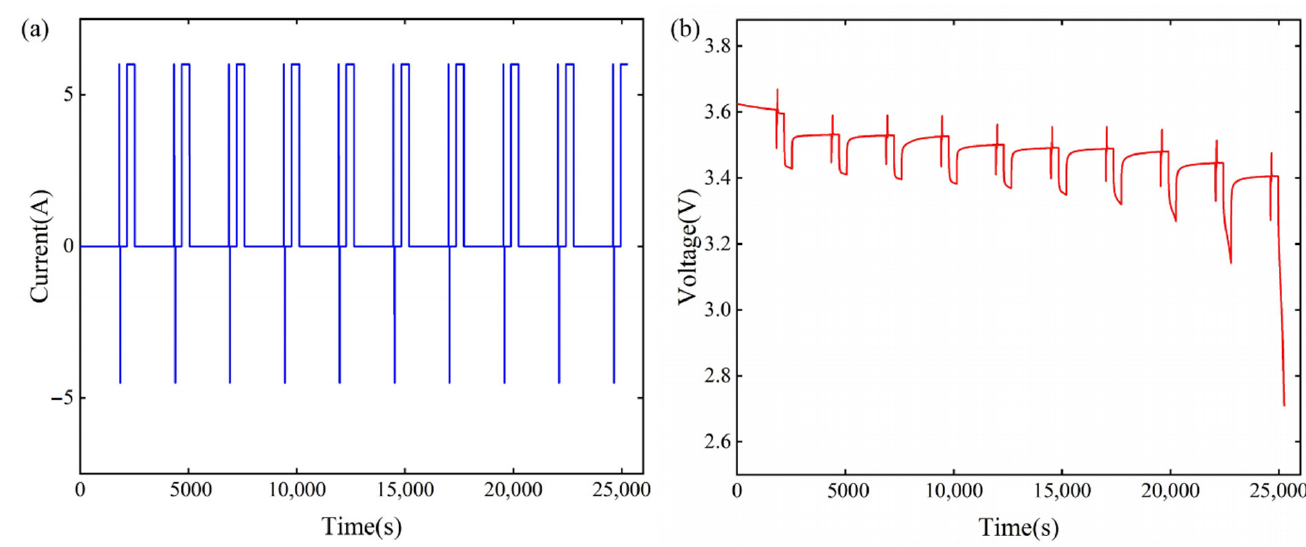
Figure 5. ( a ) HPPC operating condition current; ( b ) HPPC operating condition terminal voltage.